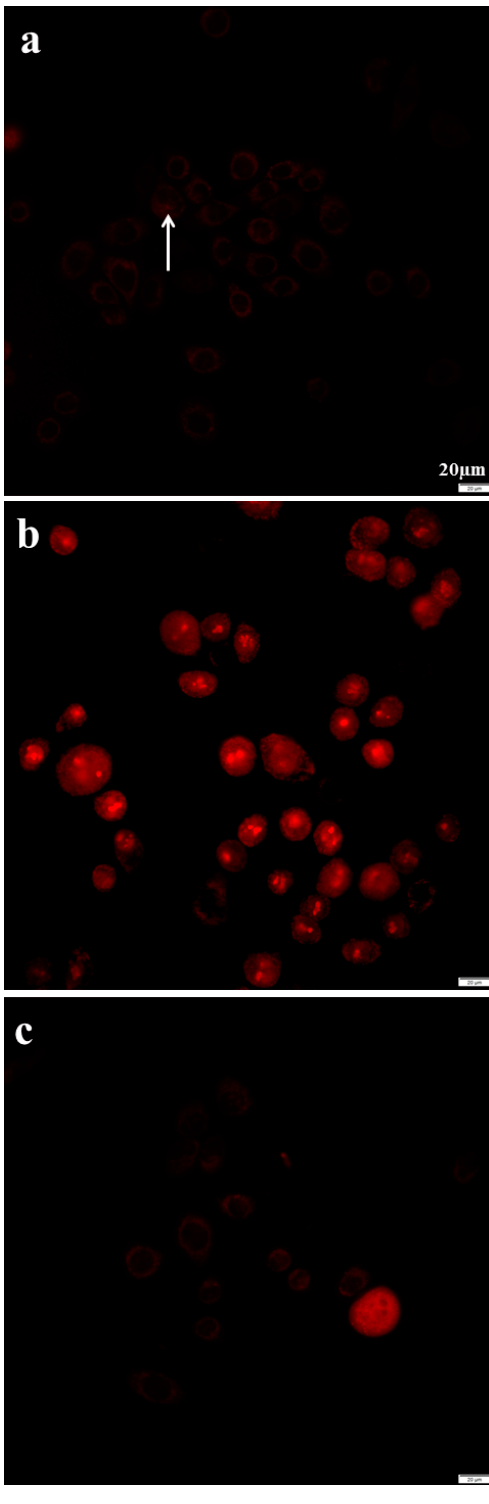
Figure 8. Azithromycin increased mitochondrial ROS of MCF-12A cells. Antioxidant SOD could prevent the production of ROS. ( a ) control; ( b ) 188 µg/mL of azithromycin for 3 h; ( c ) 188 µg/mL azithromycin + 100 u/mL SOD for 3 h; arrow: ROS.